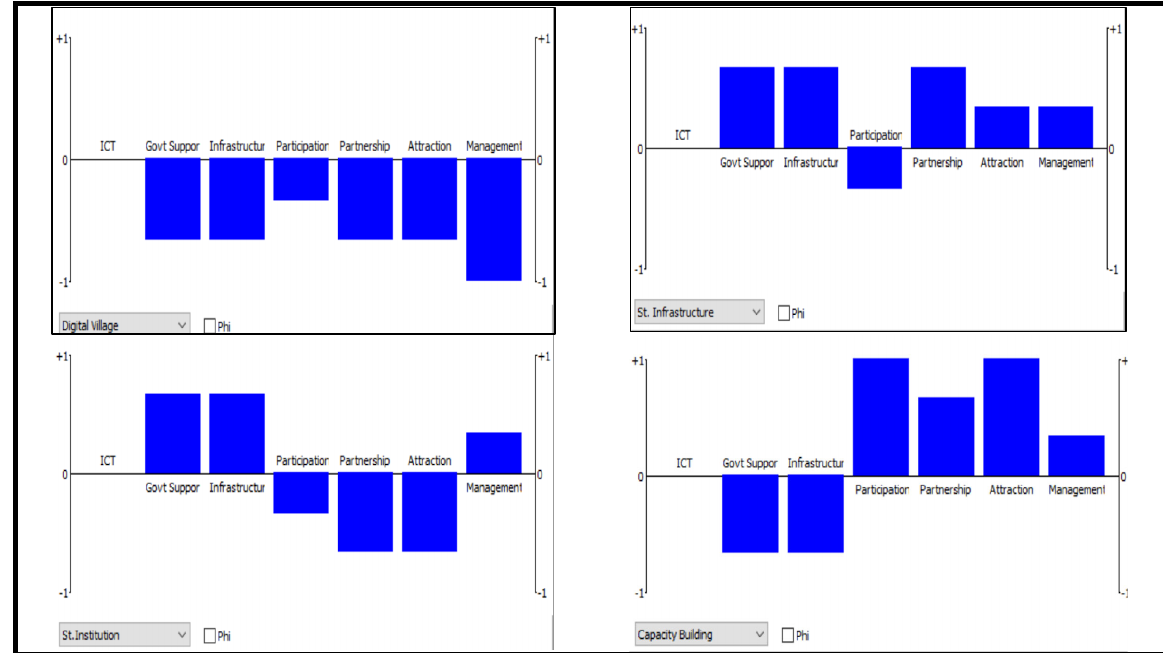
Fig. 4. Contribution of Each Attribute to Strategy